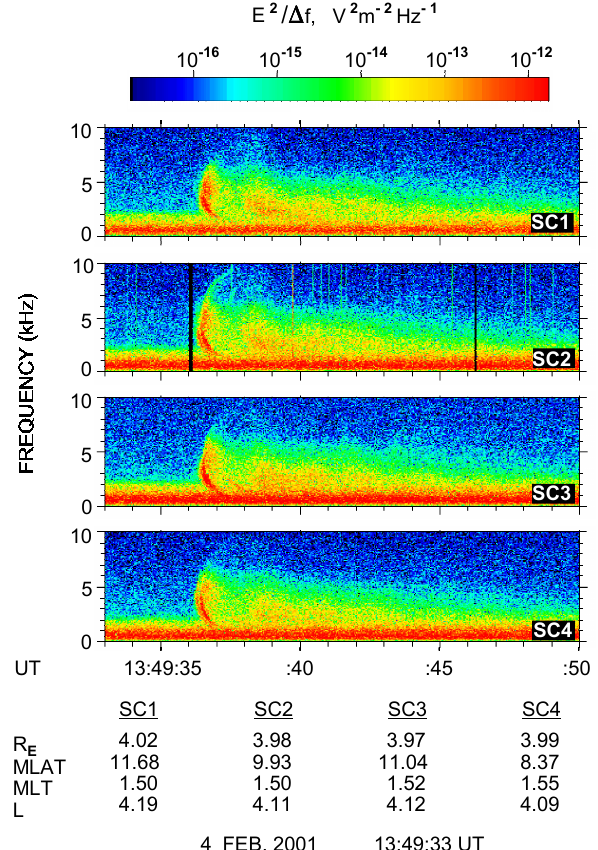
Fig. 2. Expanded time scale spectrograms from the four Cluster spacecraft showing the electric field intensities of a whistler de- tected by all four spacecraft during a perigee pass on 4 February 2001. The frequency scale is in kHz and the time, labeled UT, is the spacecraft event time in hours:minutes:seconds. The color scale at the top of the illustration gives the electric field spectral density, E 2 / 1f , in Volt 2 m − 2 Hz − 1 , with red representing the most intense and blue representing the least intense. In each case the electric field measurements are from the Y -axis electric dipole antenna. The co- ordinates of all four spacecraft, labeled SC1 through SC4, are given at the bottom of the plot for 13:49:33 UT. R is the geocentric radial distance in R E , MLAT is the magnetic latitude in degrees, MLT is the magnetic local time in hours, an L is the McIlwain L -shell parameter (McIlwain,